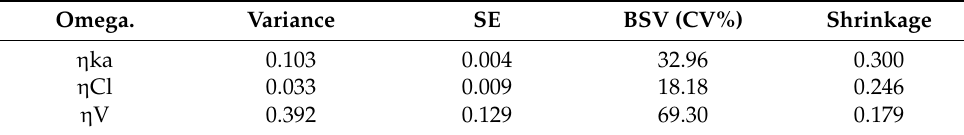
Table 2. Random effects of orally administered doxycycline (5 mg/kg) in rabbits at different ages.